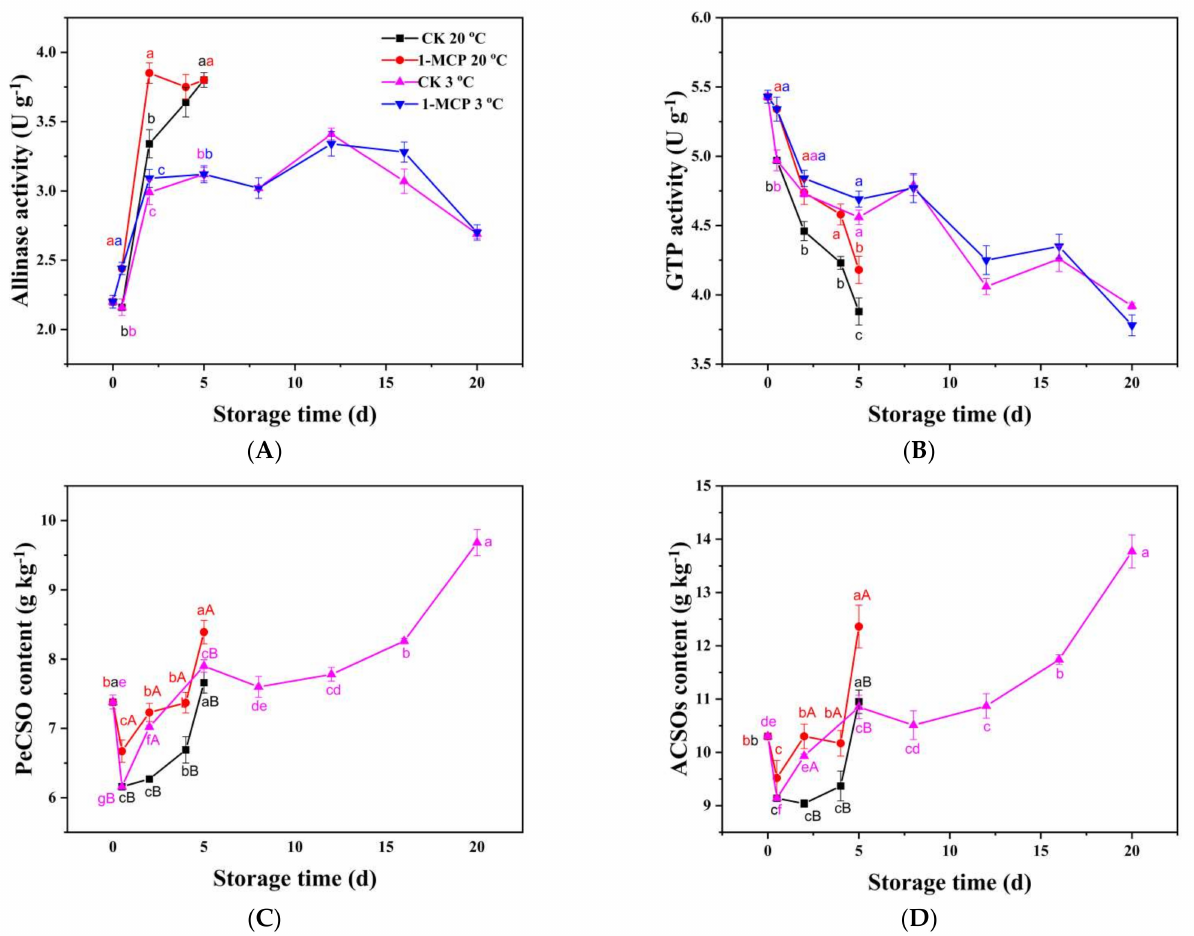
Figure 6. Allinase activity ( A ), GTP activity ( B ), PeCSO content ( C ) and ACSOs content ( D ) of 1-MCP treated and untreated chives during storage at 20 ◦ C and 3 ◦ C. The content of ACSOs in 1-MCP treated chives stored at 3 ◦ C was not determined. Data are expressed as the mean of triplicate samples. Vertical bars represent the standard errors of the means. The lower and upper case letters indicate differences among the storage time and the treatments of the chive samples,